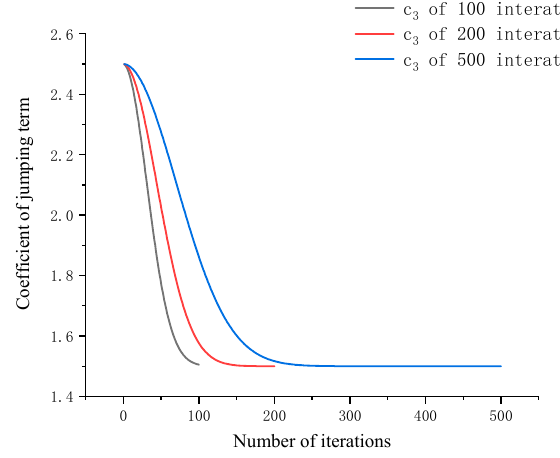
Figure 9. The trust of particles in speed jump.